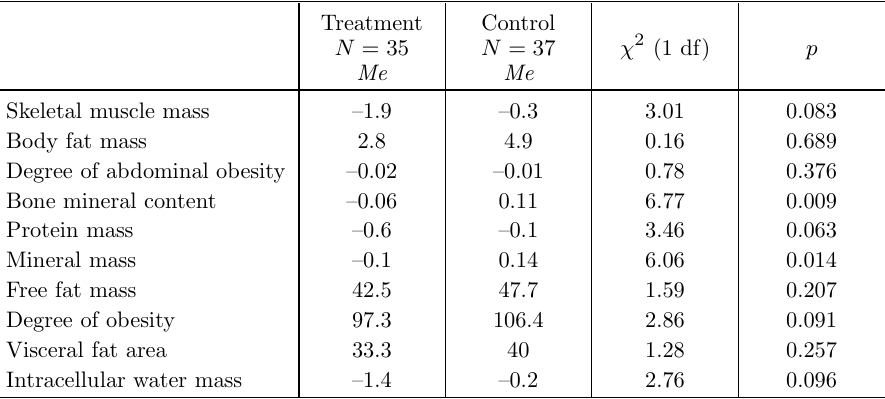
Table 4. Comparison of the variables describing the musculoskeletal system between the treatment and control group